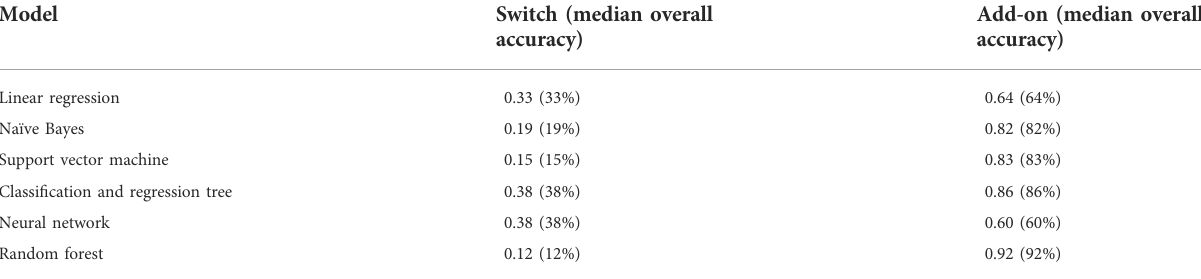
TABLE 5 Summary of all the median accuracies of the six different machine learning/deep learning models used in approach 3. Model